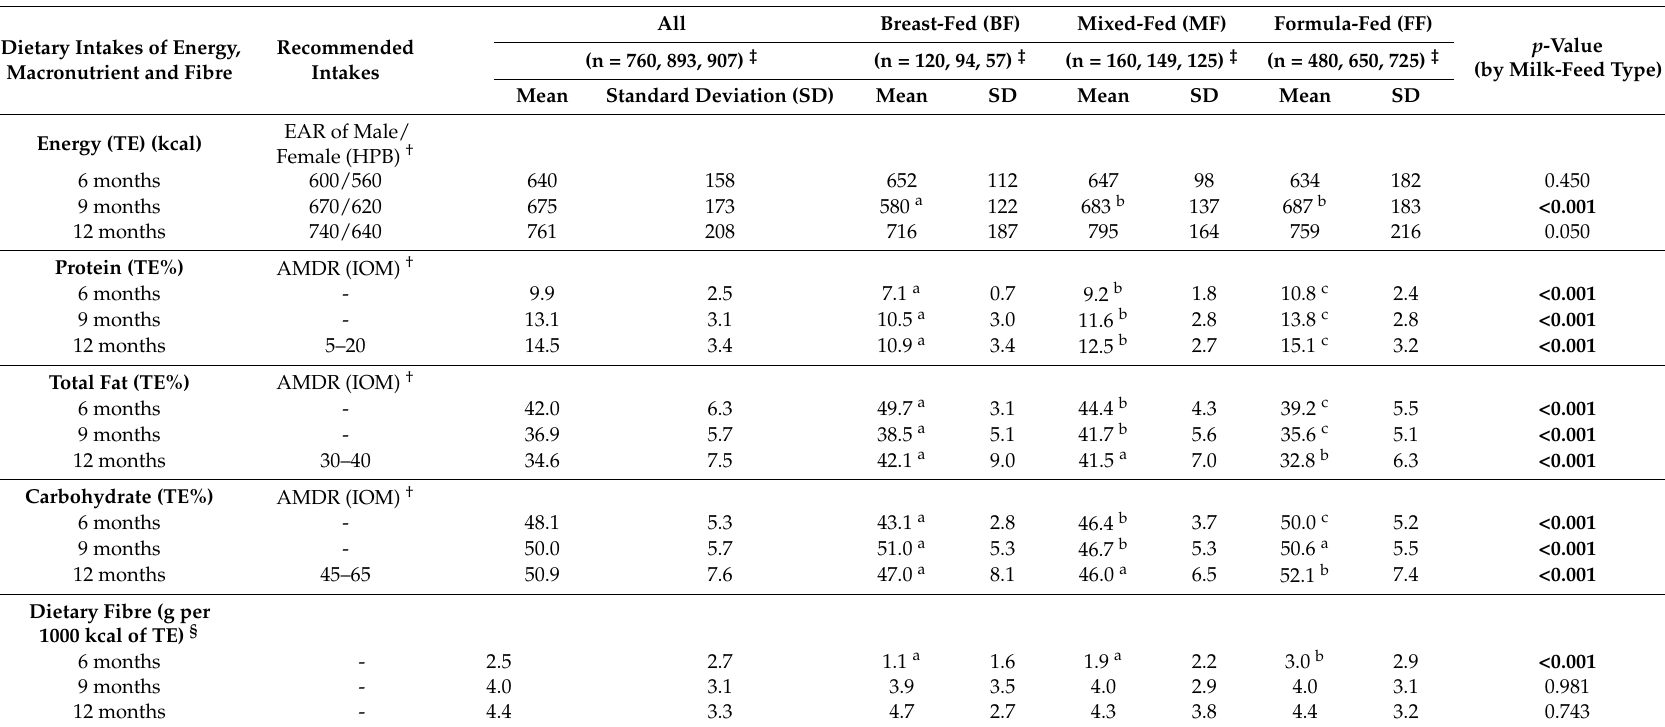
Table 2. Cross-sectional analyses of energy and energy-adjusted macronutrient and dietary fibre intakes of all infants, and stratified by type of milk feed.